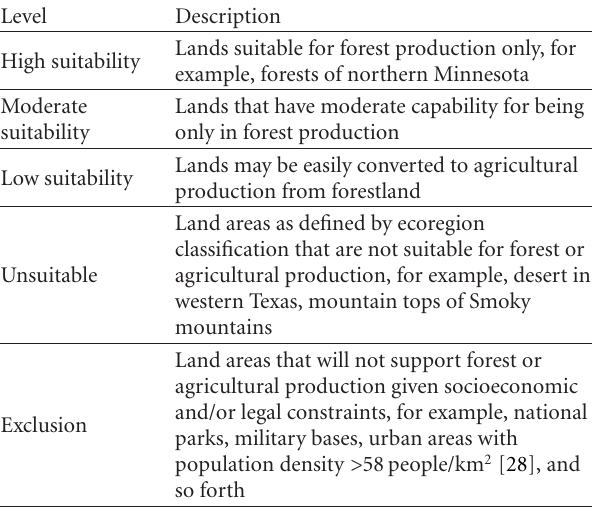
Table 2: Definitions of landscape suitability